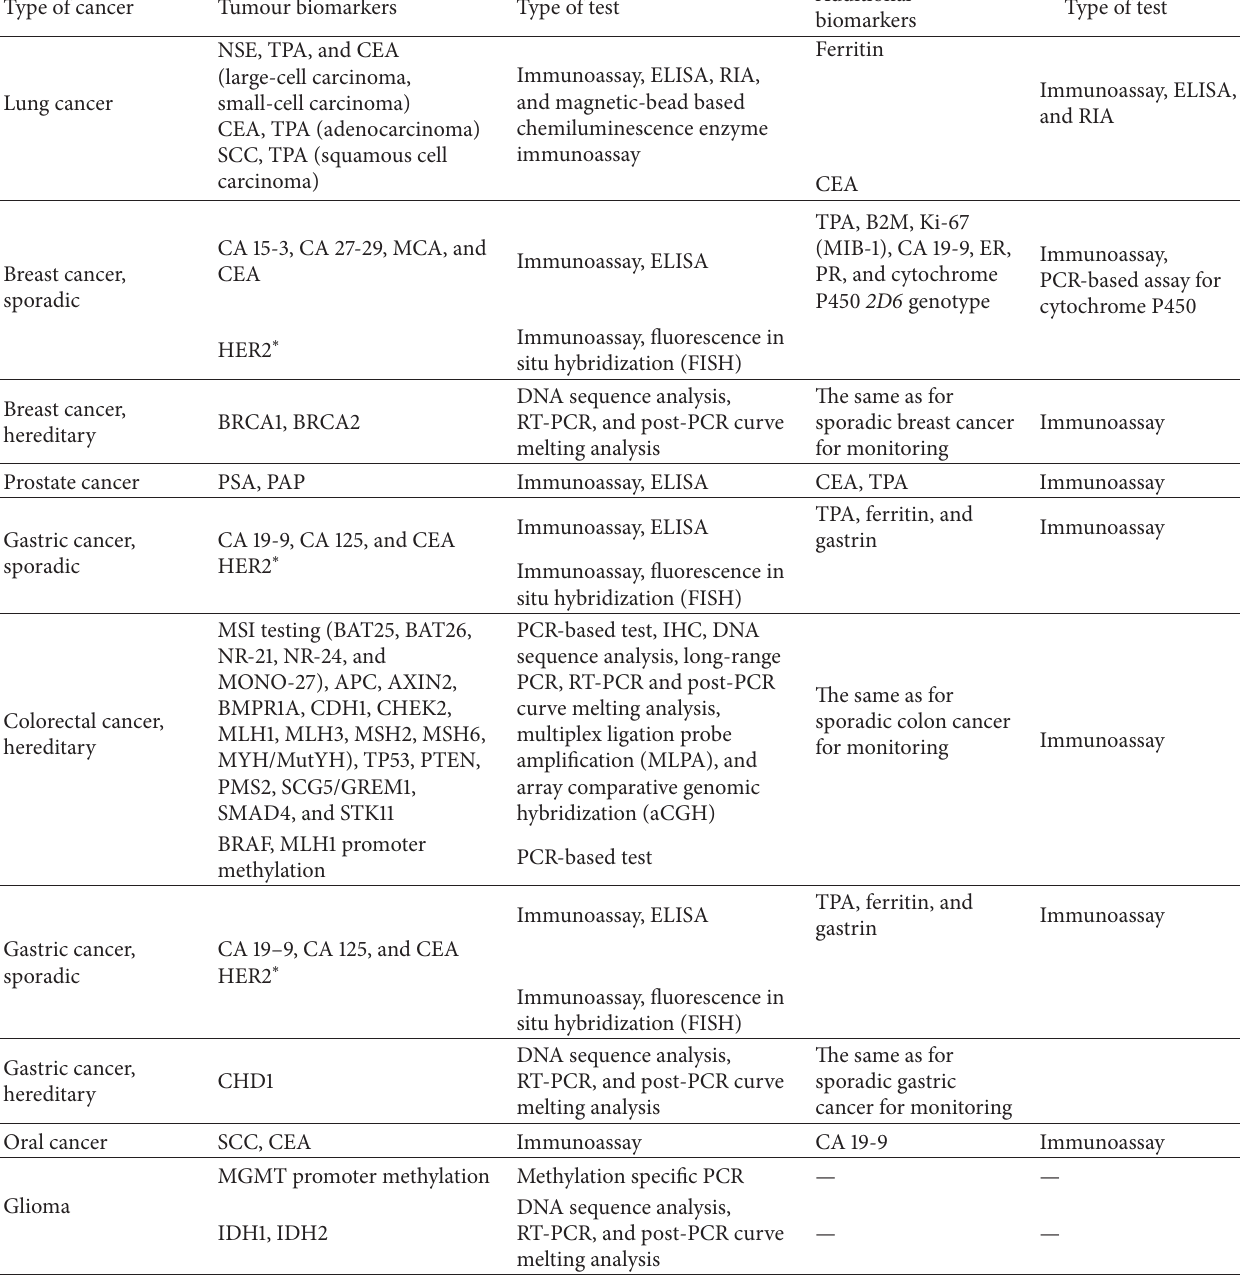
Table 1: Selection of commonly used blood molecular and protein biomarkers for the management (diagnosis, monitoring recur- rence/detecting metastatic spread, and selection of suitable treatment/monitoring treatment response) of cancers in clinical